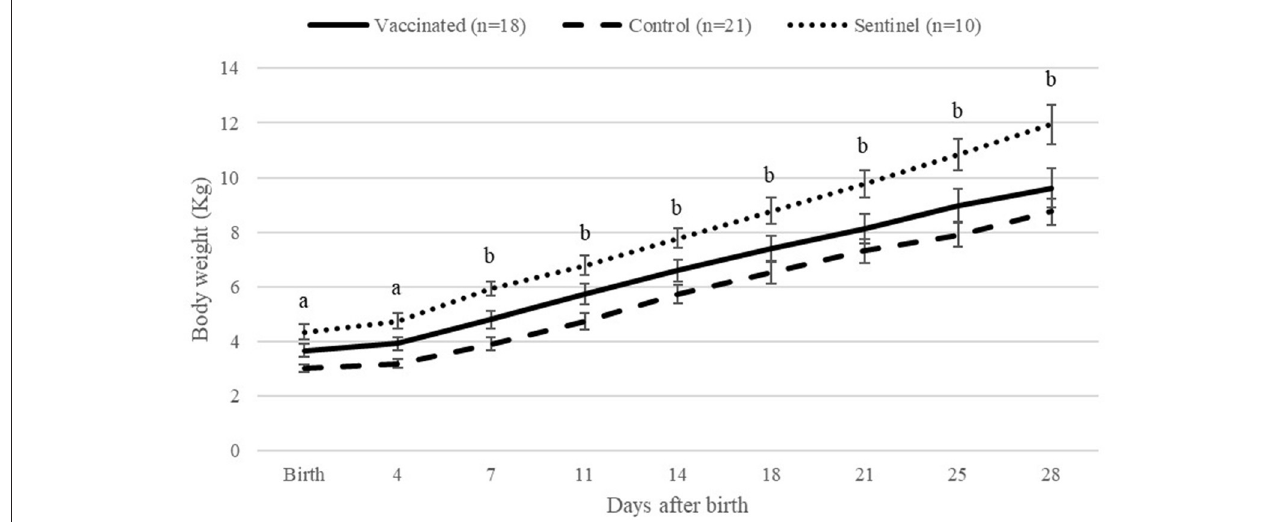
FIGURE 5 | Average of lamb body weights per group from birth to 28 days after birth per day. a Indicates significant differences ( P < 0.05) between the control and other groups (vaccinated and sentinel). b Indicates significant differences ( P < 0.05) between the control and sentinel